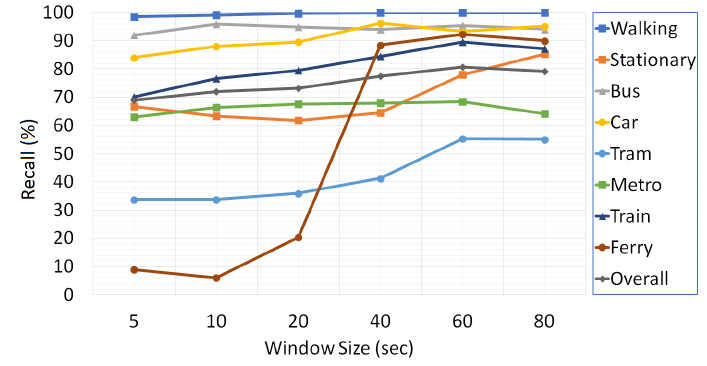
Figure 7. The effect of window size on the classification